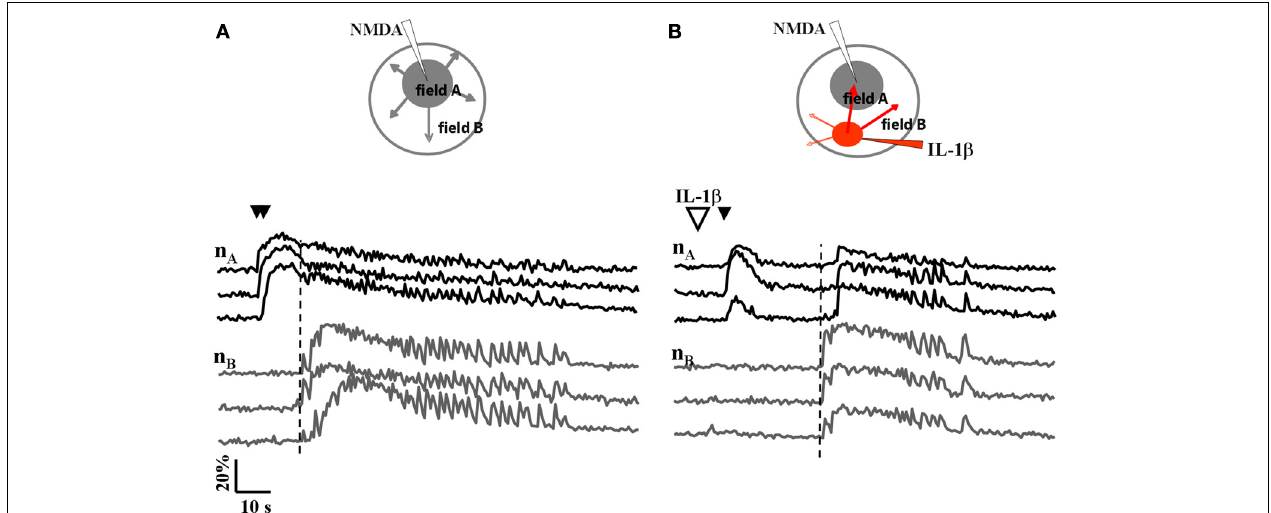
FIGURE 3 | A focal ictal-like event can initiate at the site of IL-1 β local applications. (A) Schematic view and neuronal Ca 2 + changes during a focal ictal evoked by a double NMDA pulse (double black arrows). The focal ictal-like event arose in field A neurons (nA), close to the NMDA pipette, and then propagate to neurons in B (nB). (B) In the same slice, after IL-1 β applications (red spot in the inset, and big white arrow), a focal ictal was